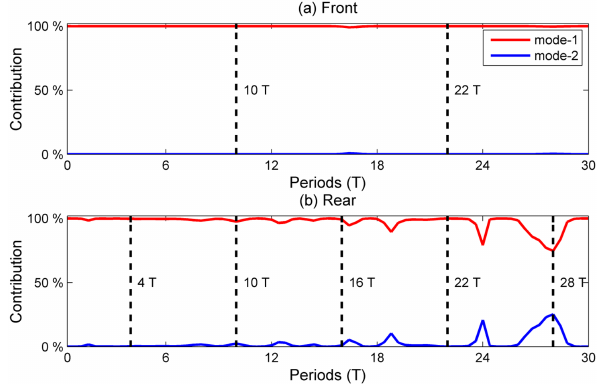
Figure 11. Percent contributions of mode-1 and mode-2 to the total kinetic energy in the control experiment (case O5 with (cid:49) = 0) from 0 to 30 T at the (a) front and (b) rear of the mode-2 ISW; the dash lines indicate the cross sections where the modal structures of waves were shown in Fig. 12.